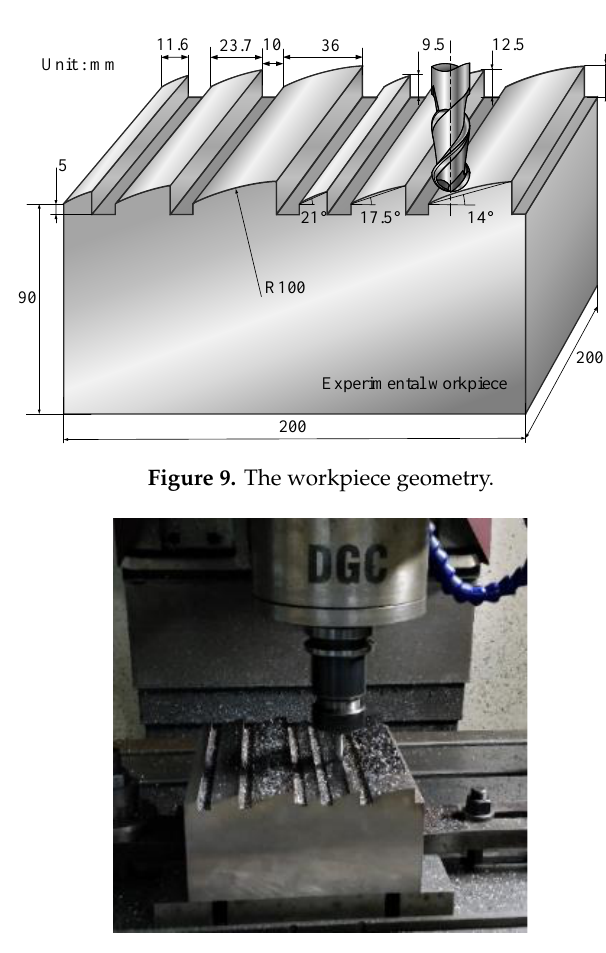
Figure 10. Part surface machining.